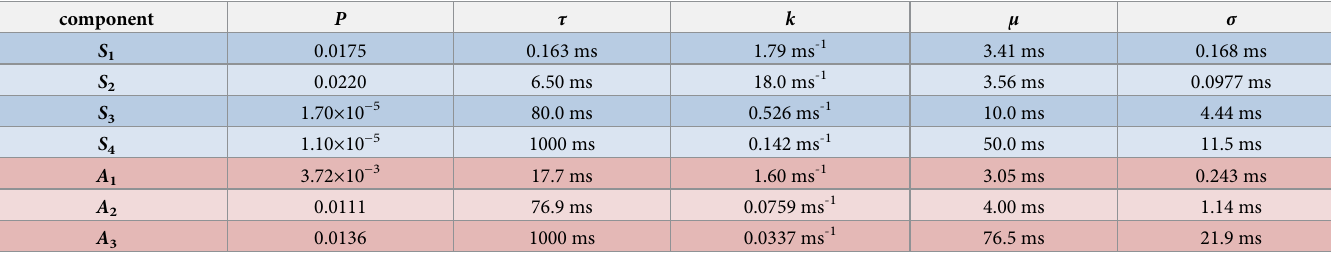
Table 2. Spike-Evoked Release Rate